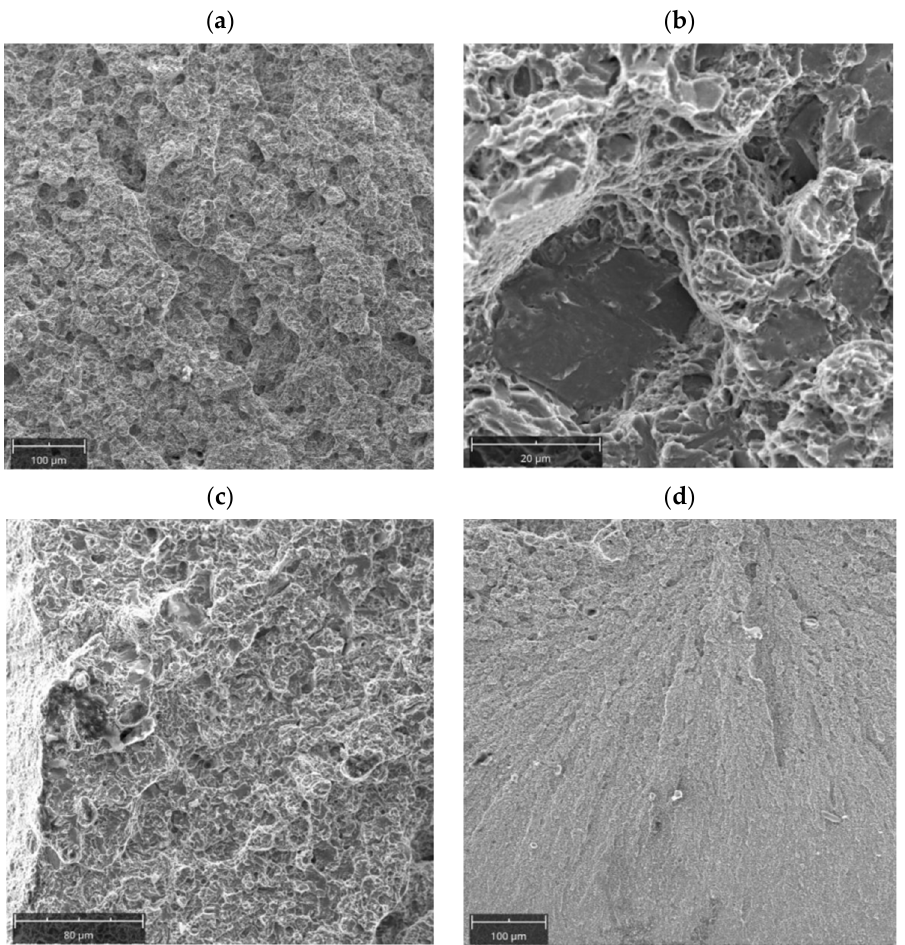
Figure 17. Microscopic images of the fracture surface of the Charpy sample: ( a ) quasi-brittle fracture, ( b ) brittle fracture along the grain boundaries, ( c ) area of dominating ductile fracture, ( d ) area close to the impact area of the Charpy hammer.